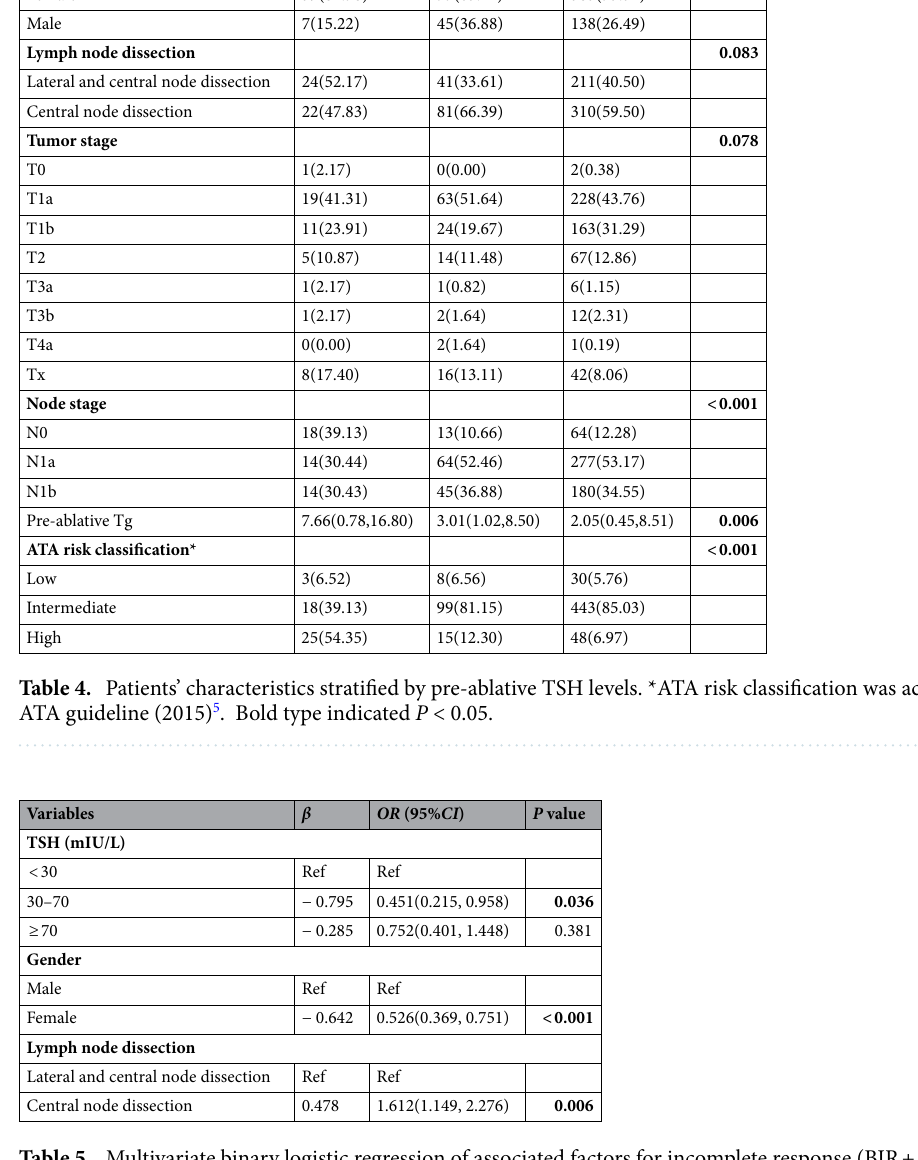
Table 5. Multivariate binary logistic regression of associated factors for incomplete response (BIR + SIR) after RRA. Bold type indicated P <